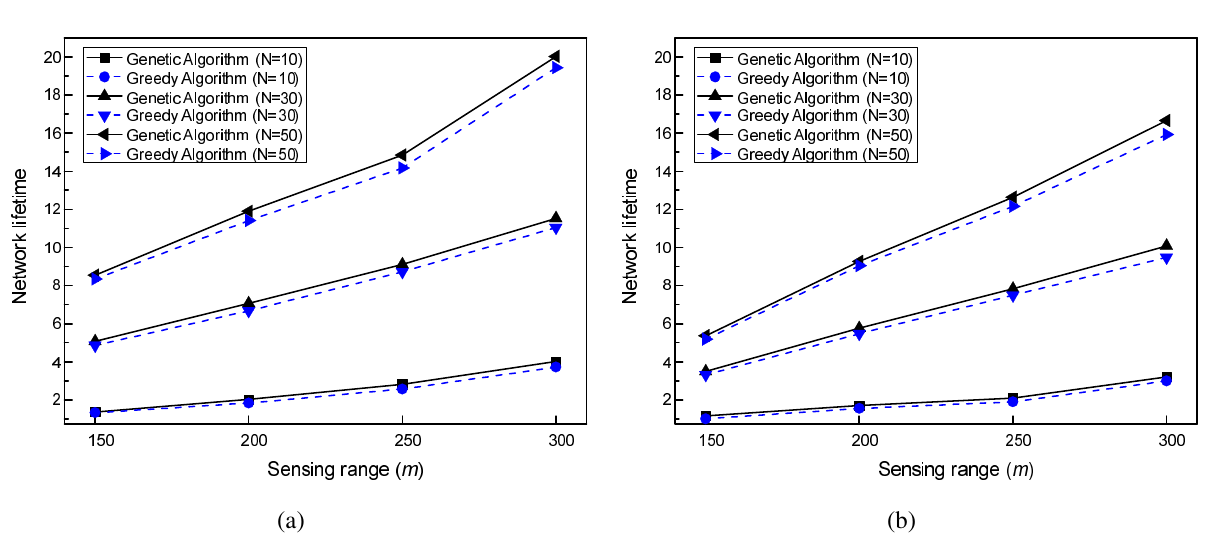
Comparison of network lifetimes according to changes in sensing